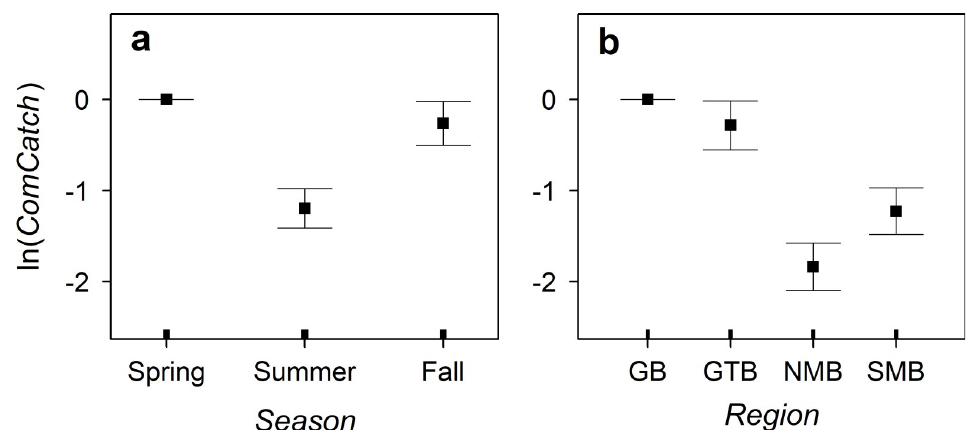
Fig 5. The relationships between commercial cisco catch in tonnes ( ComCatch ) and season ( Season ) and Lake Michigan region ( Region ), with adjustments for gear type and fishing effort, based on the generalized additive model fitted to the State of Michigan’s commercial catch data collected in 1930–1932. The points represent the predicted values and the error bars represent +/ − one standard error. Ticks above the horizontal axis represent the relative sample size.